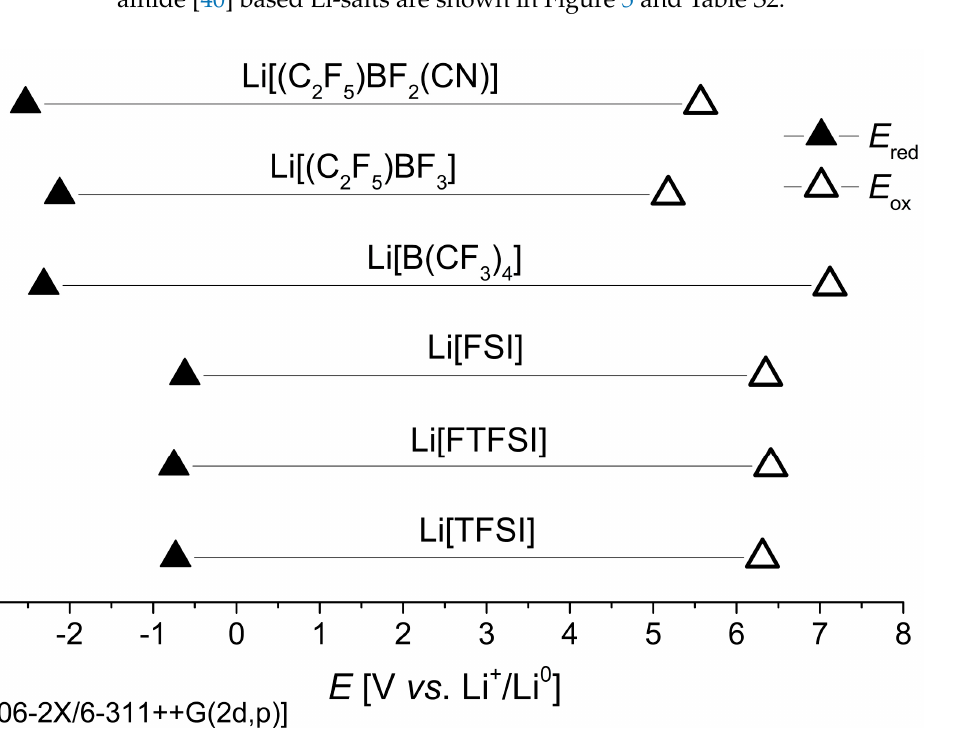
Figure 5. The calculated electrochemical reductive ( E red ) and oxidative ( E ox ) stability limits of the borate anion-based Li-salts from this work (compared to those based on the sulfonamide anions [FSI] − , [FTFSI] − , and [TFSI] − from reference [40]). The calculated oxidative stability limit of Li[B(CF 3 ) 4 ] (7.12 V vs. Li + /Li 0 ) is significantly higher compared to the heteroleptic borate and sulfonamide anions. The smaller E ox val- ues of 5.57 and 5.18 V vs. Li + /Li 0 calculated for Li[(C 2 F 5 )BF 2 (CN)] and Li[(C 2 F 5 )BF 3 ] indicate that these anions may be restricted to operating at lower voltages (<5.5 V), such as 4 V class LMBs. In contrast, the calculated E ox value of Li[B(CF 3 ) 4 ] would suggest it is suitable for batteries using high-voltage cathode materials.